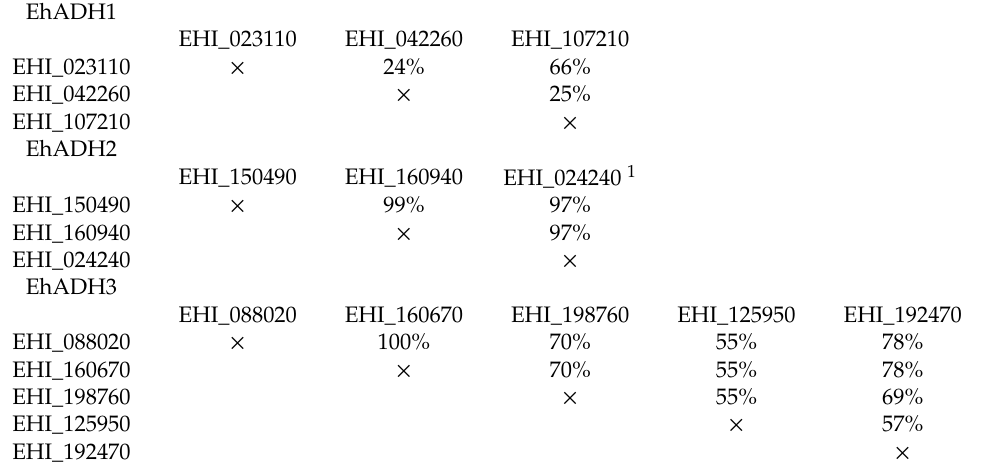
Table 2. Amino acid sequence identity of the various alcohol dehydrogenases of E.